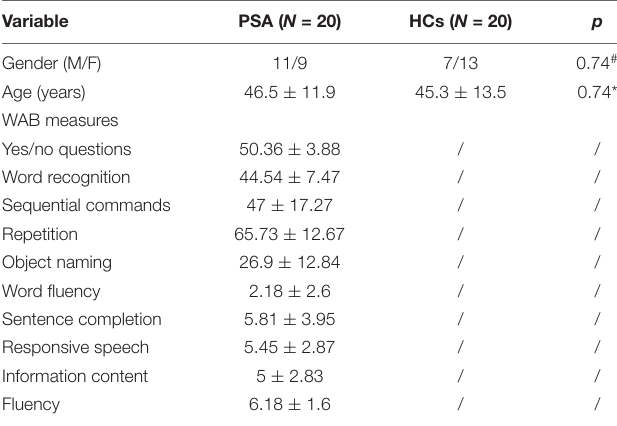
TABLE 1 | Demographics and clinical